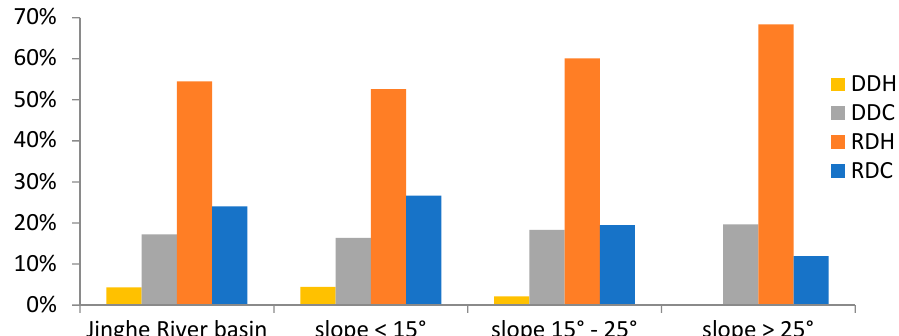
Figure 6. Area statistics of the driving factors in NPP change in the Jinghe River basin and different slopes. RDC is the restoration of vegetation dominated by meteorological conditions, RDH is the restoration of vegetation dominated by human activities, DDC is the degradation of vegetation dominated by meteorological conditions, DDH is the degradation of vegetation dominated by human activities.